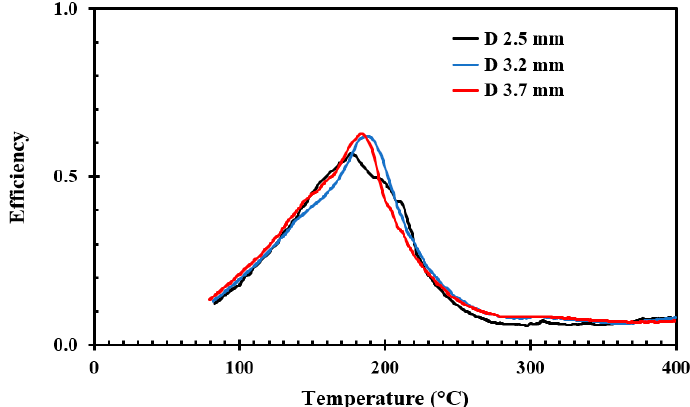
Figure 8. Cooling efficiency for pure water droplets with 25 cm impingement height for 60° inclination and various droplet diameters. Droplet speed 2.2 m/s.